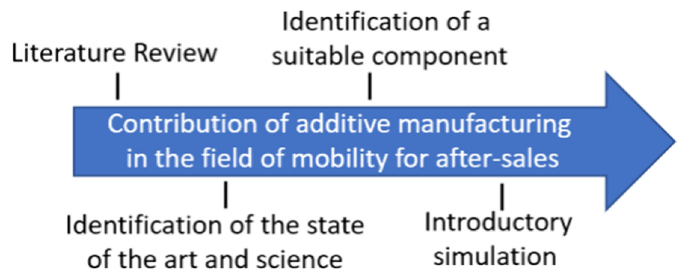
Figure 2. Theoretical research procedure.